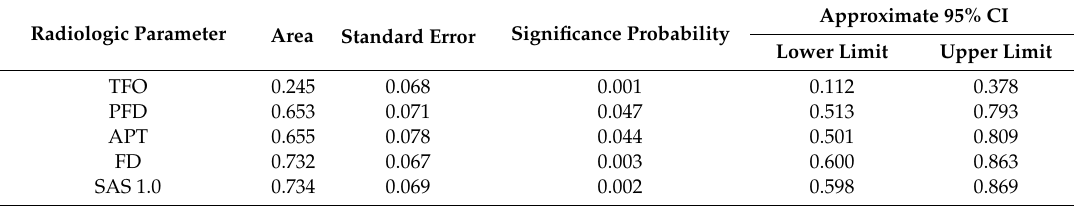
Table 3. The receiver-operating characteristic curve analysis of the ratio of parameters (injured / intact).